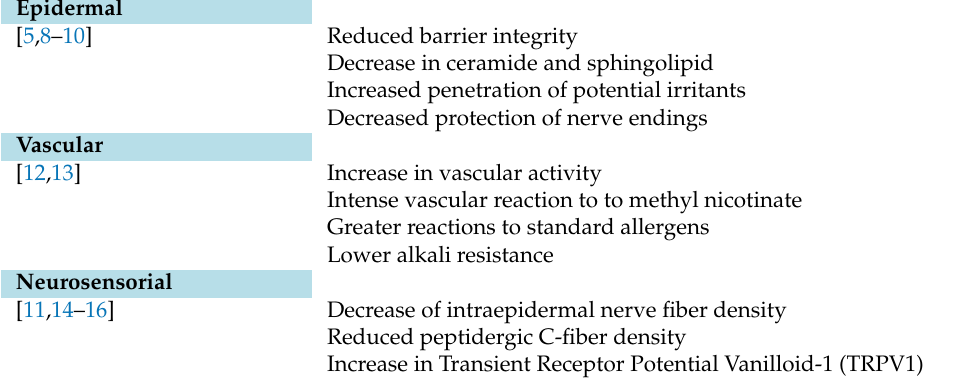
Table 1. Some Physiological Elements Contributing to